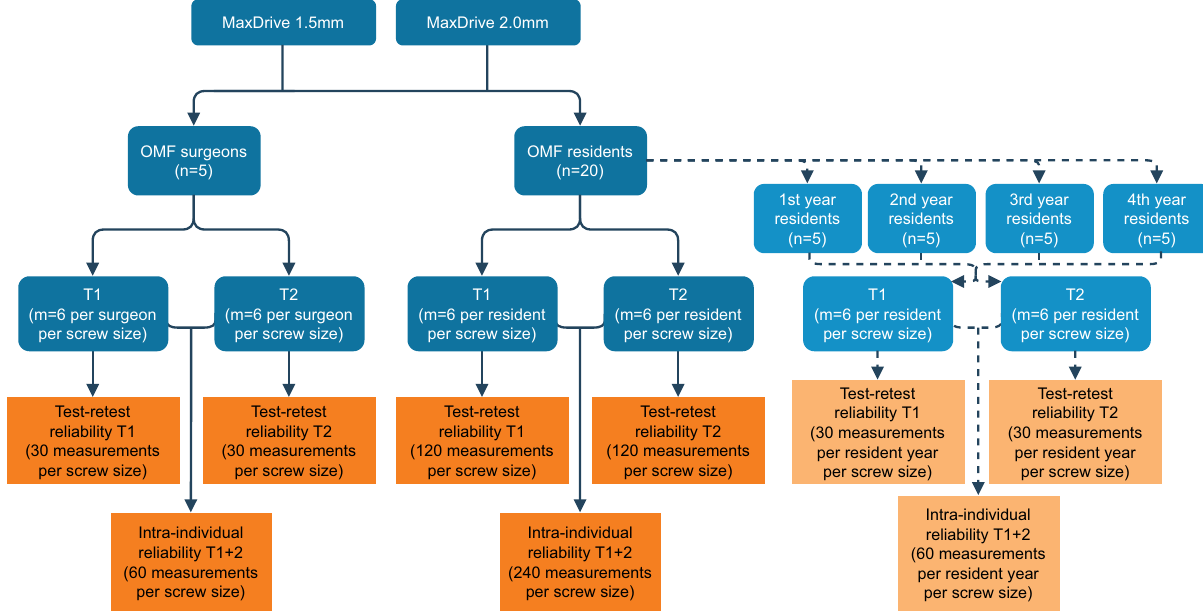
Figure 2. Flowchart of the study procedures to assess the test–retest (at T1 and T2) and intra-individual reliability of the two main groups (i.e., oral and maxillofacial surgeons and residents) and the subgroups (i.e., the different residency years; the dashed lines and lighter colour boxes). OMF oral and maxillofacial, n number of participants, m number of measurements, T 1 at baseline, T 2 after 2